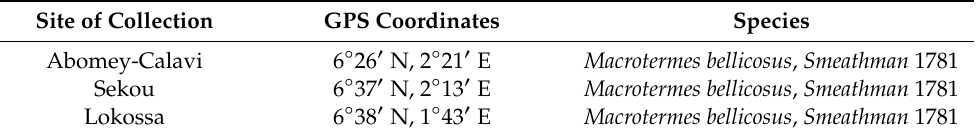
Table 3. Overview of collected M. bellicosus samples (including termite mound and fungus comb) and corresponding GPS